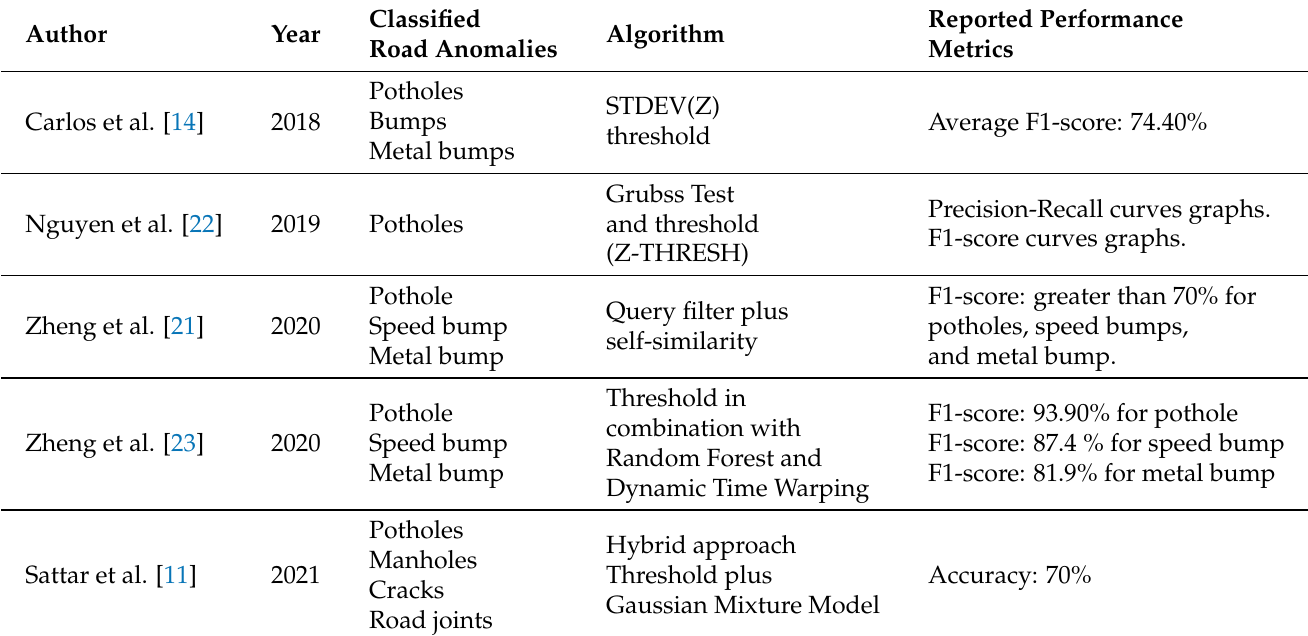
Table 3. Methods used for road anomaly detection and classification based on threshold techniques.